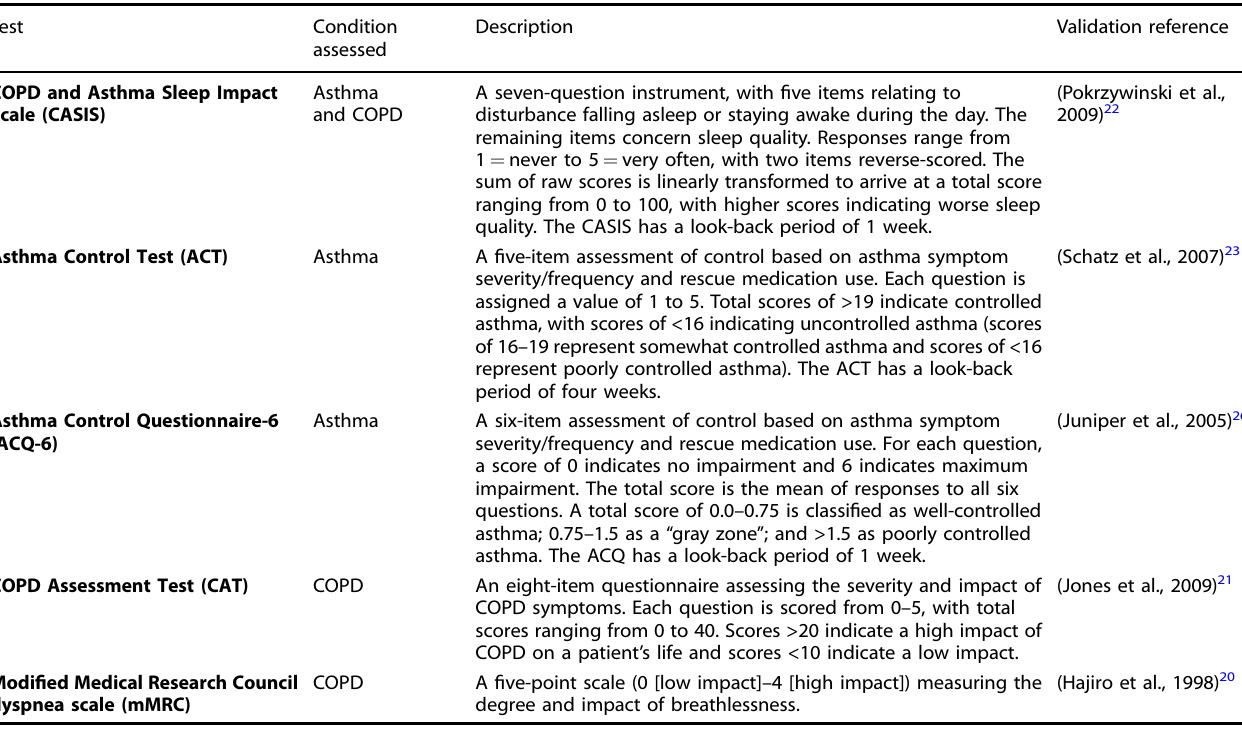
Table 1. Validated instruments included in the disease-speci fi c